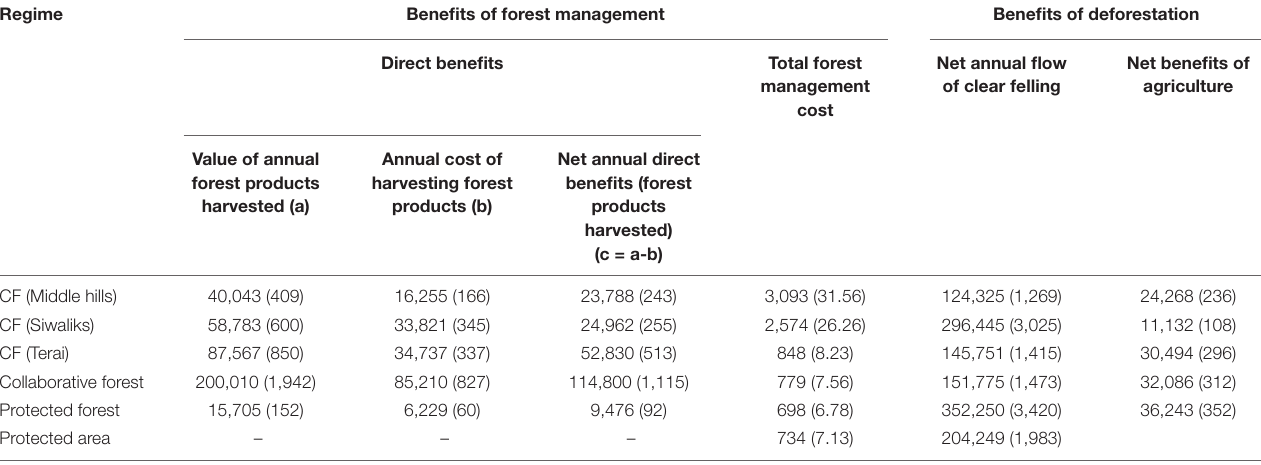
TABLE 2 | Costs and benefits of forest management activities per ha in NPR (USD in parentheses).